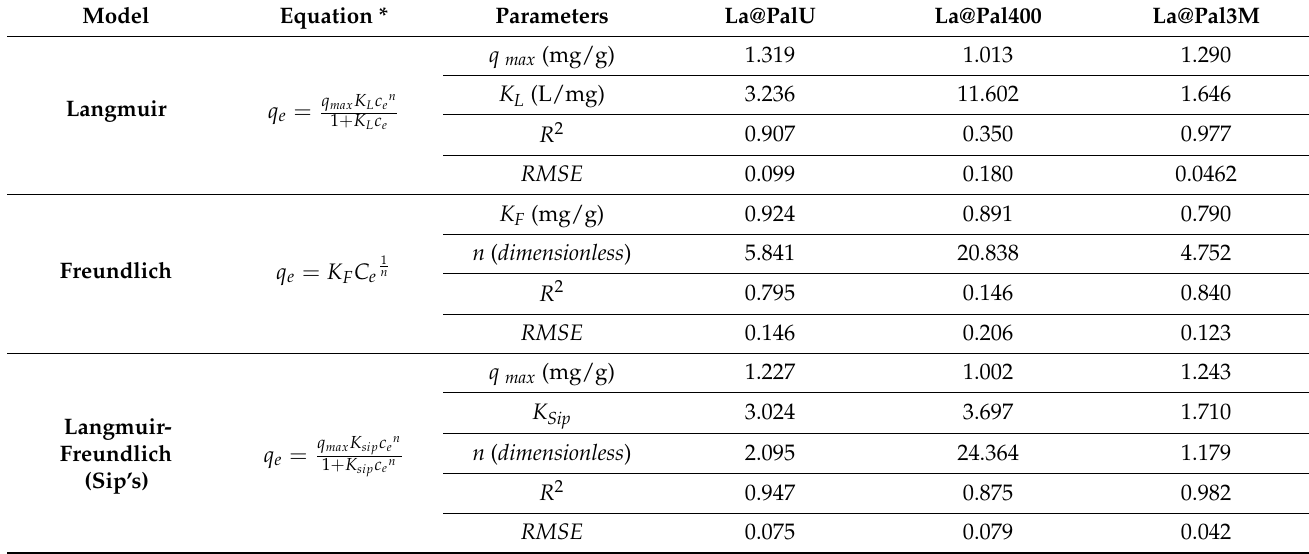
Table 1. Model parameters of adsorption isotherm of phosphate by the modified palygorskite materials.